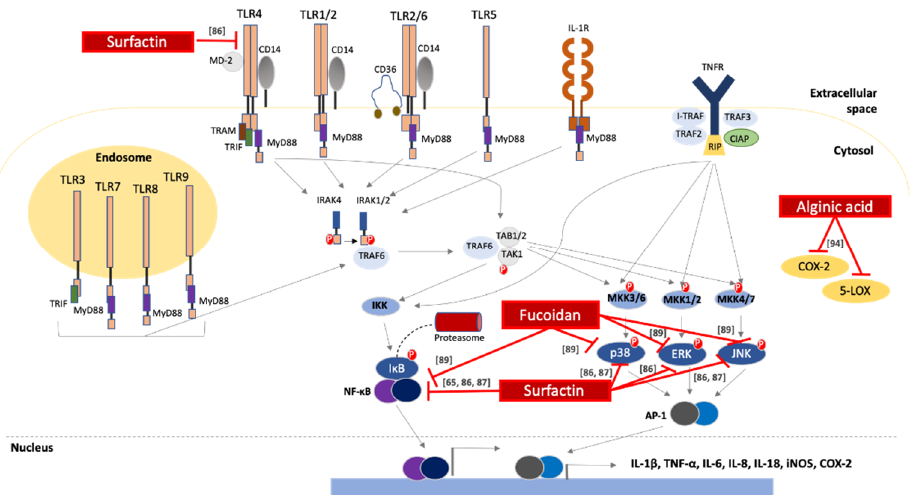
Figure 1. Anti-inflammatory activity of marine-derived SAAs. Biosurfactants halt the production of pro-inflammatory mediators by interfering with pathways induced by the stimulation of Toll-like receptors, interleukin-1 receptor and Tumor Necrosis Factor- α receptor. These compounds directly inhibit key molecules of the IKK / NF- κ B, p38 MAPK, MAPK / ERK and JNK signaling pathways or inactivate cyclooxynase-2 (COX-2) and 5-lipoxygenase (5-LOX) that catalyze the production of inflammatory molecules. TLR, Toll-like receptor; MD-2 (encoded by the LY96 gene): lymphocyte antigen 96; IL, interleukin; IL-1R, interleukin-1 receptor; MyD88, myeloid di ff erentiation primary response 88; CIAP, calf intestinal alkaline phosphatase; RIP, ribosome-inactivating protein; TRIF, toll / interleukin-1 receptor-like protein (TIR)-domain-containing adaptor-inducing interferon- β ; TRAM, TRIF-related adaptor molecule; TRAF, tumor necrosis factor receptor-associated factor; TAB1 / 2, tumor growth factor- β (TGF- β )-activated kinase 1; TAK, TGF- β activated kinase 1; IKK, I κ B kinase; MKK, mitogen activated protein (MAP) kinase; COX-2, cyclooxygenase-2; 5-LOX, 5-lipoxygenase; iNOS, inducible nitrogen oxide synthase; NF- κ B, nuclear factor κ B; ERK, extracellular signal activated kinase; JNK, c-Jun N-terminal kinase; AP-1, activator protein-1; IRAK, IL-1 receptor associated kinase.